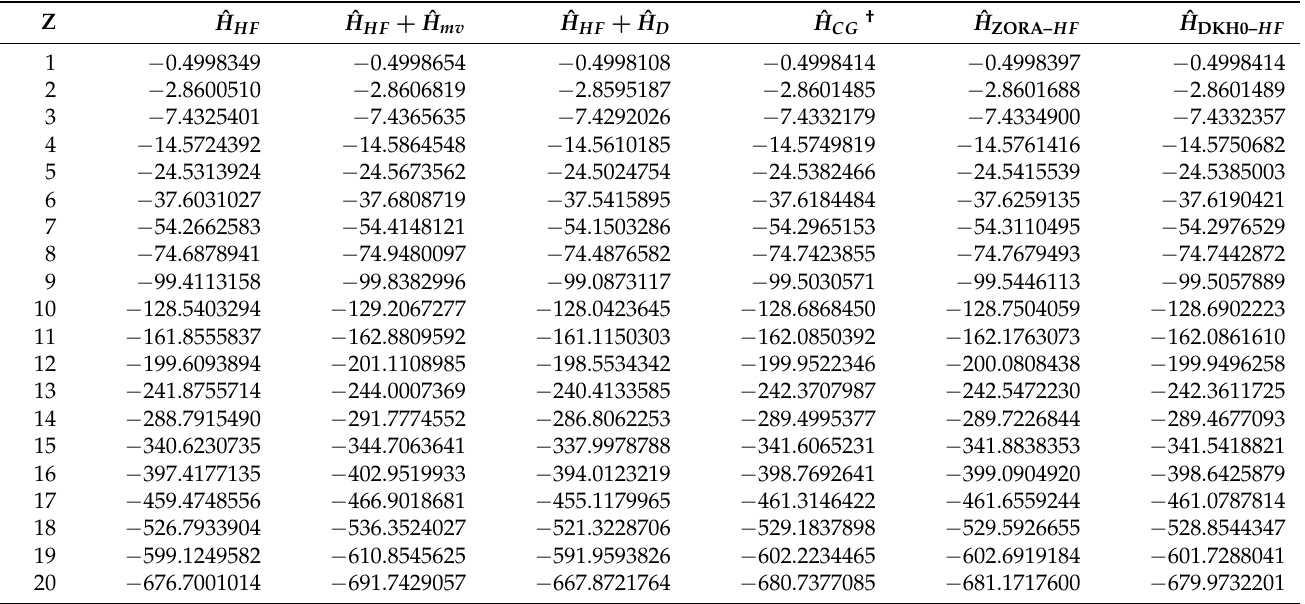
Figure 1. Spin-orbit coupling current density vector field for the Co 3 + atom with spin multiplicity 2 S + 1 = 13 evaluated on the xy plane for a magnetic field applied in the z direction. Table 1. Variational energies in hartree, obtained with the Hartree–Fock approximation considering the different corrections to the Hamiltonian adopting the ATZP-ZORA basis set for atoms with atomic number Z that comes from 1 to